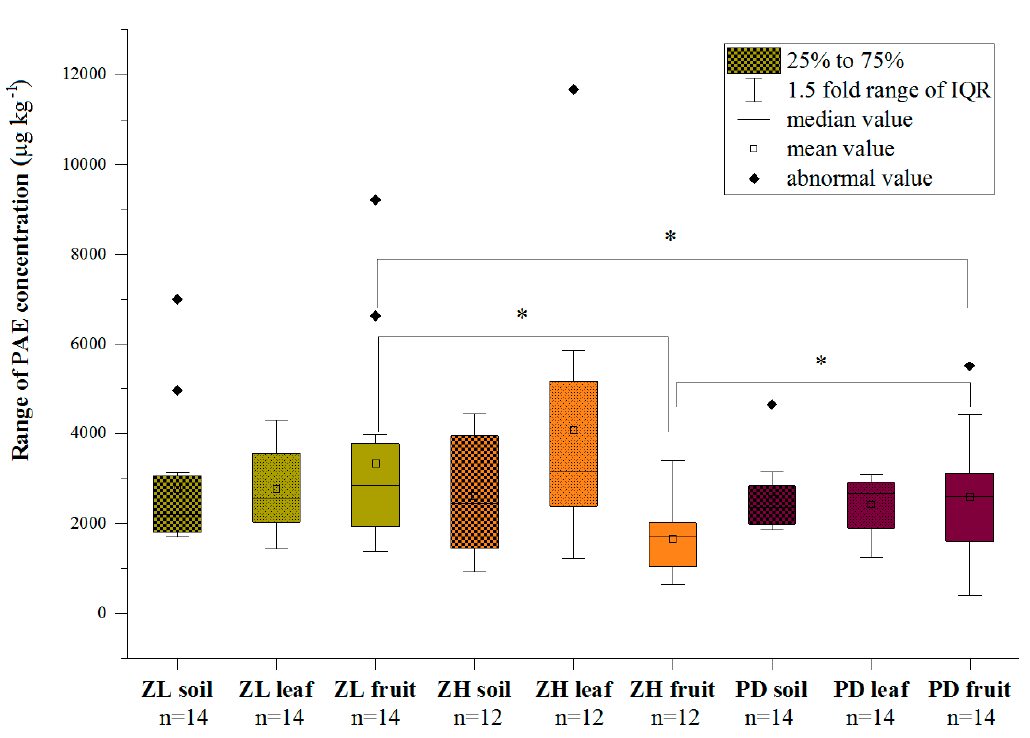
Figure 2. Concentration range of PAEs in 120 samples from 40 selected plastic greenhouses in three study areas. *: significant difference at p < 0.05 compared with the same sampling group. Refer the denotes to Figure 1.